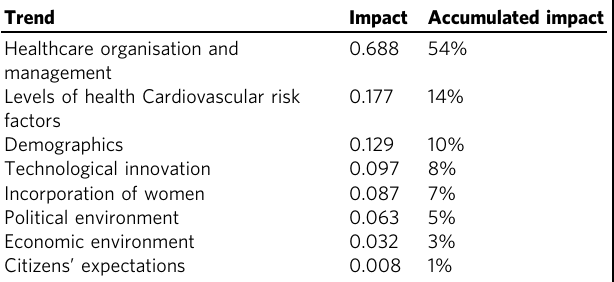
Table 2 Impact and accumulated impact of the most relevant trends for the future of cardiology identi fi ed by the Spanish Society of